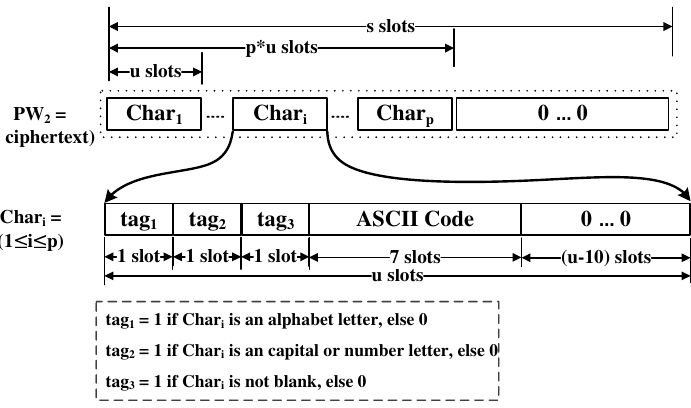
Figure 8. Encoding the characters in password to PW 2